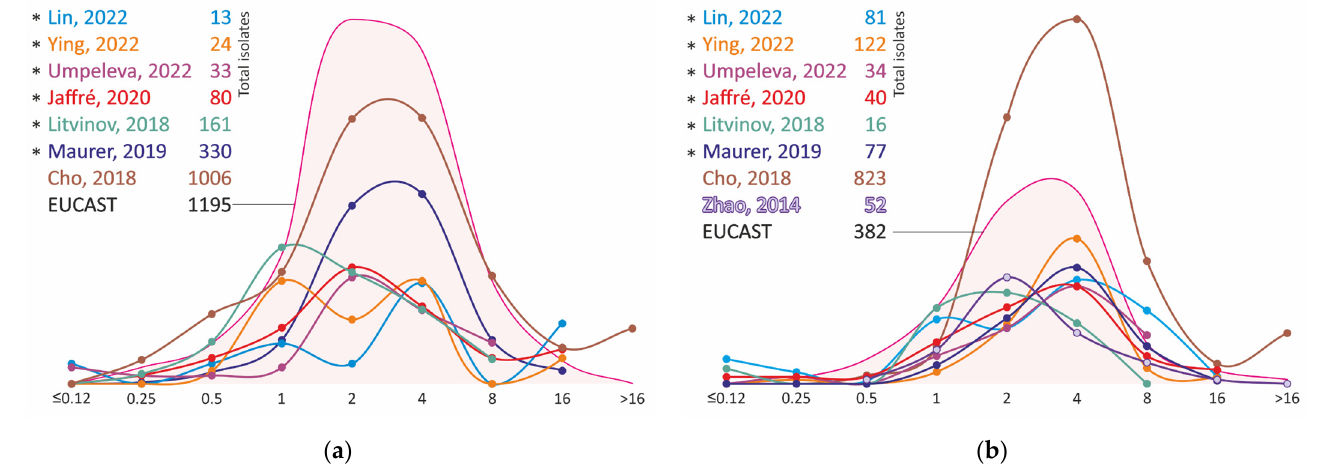
Figure 4. Moxifloxacin MIC distribution for clinical isolates of M. avium ( a ) and M. intracellulare ( b ). * MIC obtained using Sensititre SLOMYCO plates.